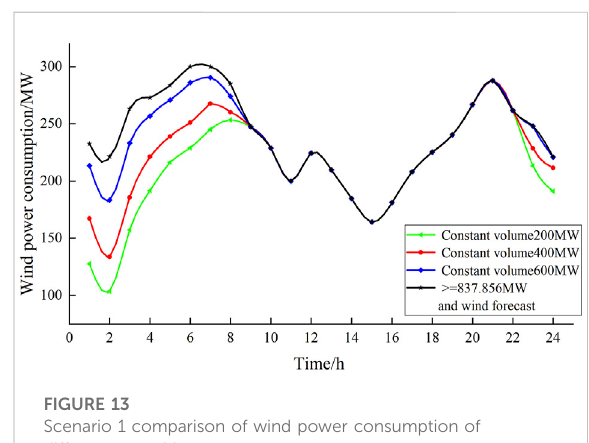
FIGURE 13 Scenario 1 comparison of wind power consumption of different capacities.